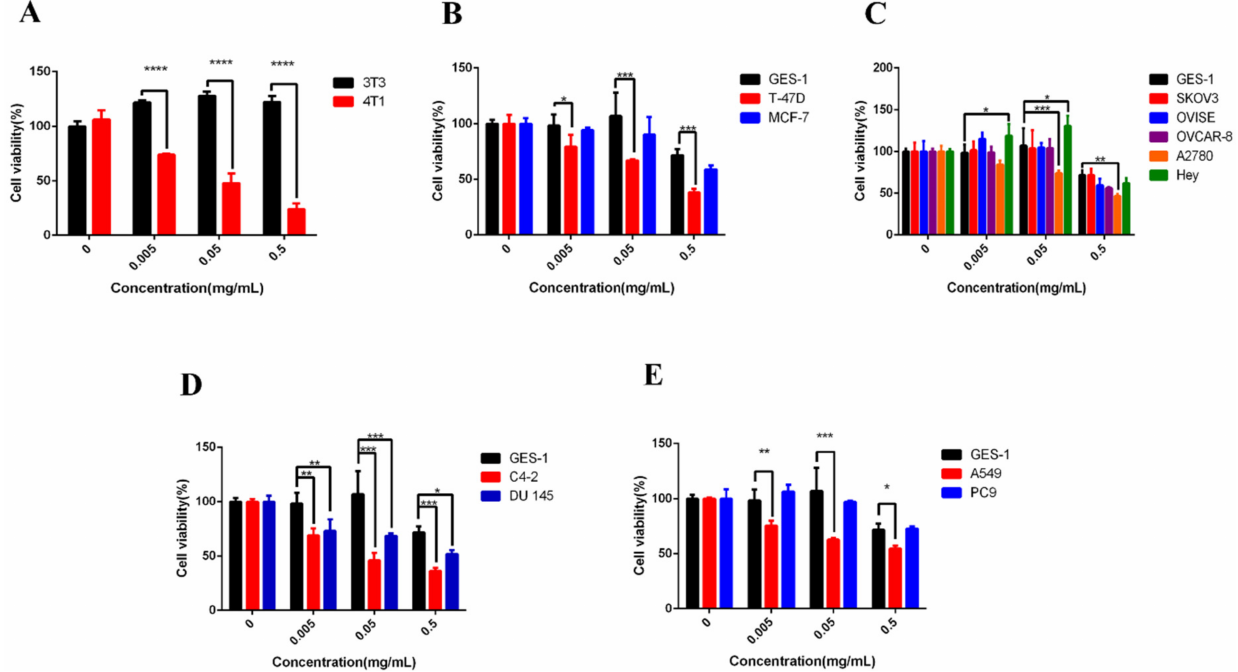
Figure 1. Effect of polyphenol oxidase on ( A ) breast cancer cell 4T1 and mice normal fibroblast 3T3, ( B ) human breast cancer cells MCF-7, T-47D and human gastric normal cell GES-1, ( C ) human gastric normal cell GES-1 and human ovarian cancer cells A2780, Hey, OVISE, OVCAR-8, SK-OV-3, ( D ) human gastric normal cell GES-1 and human prostate cancer cells C4-2, DU 145, ( E ) human gastric normal cell GES-1 and human lung cancer cells A549, PC9; bars, SE (* p < 0.05; ** p < 0.01; *** p < 0.001; **** p < 0.0001 versus